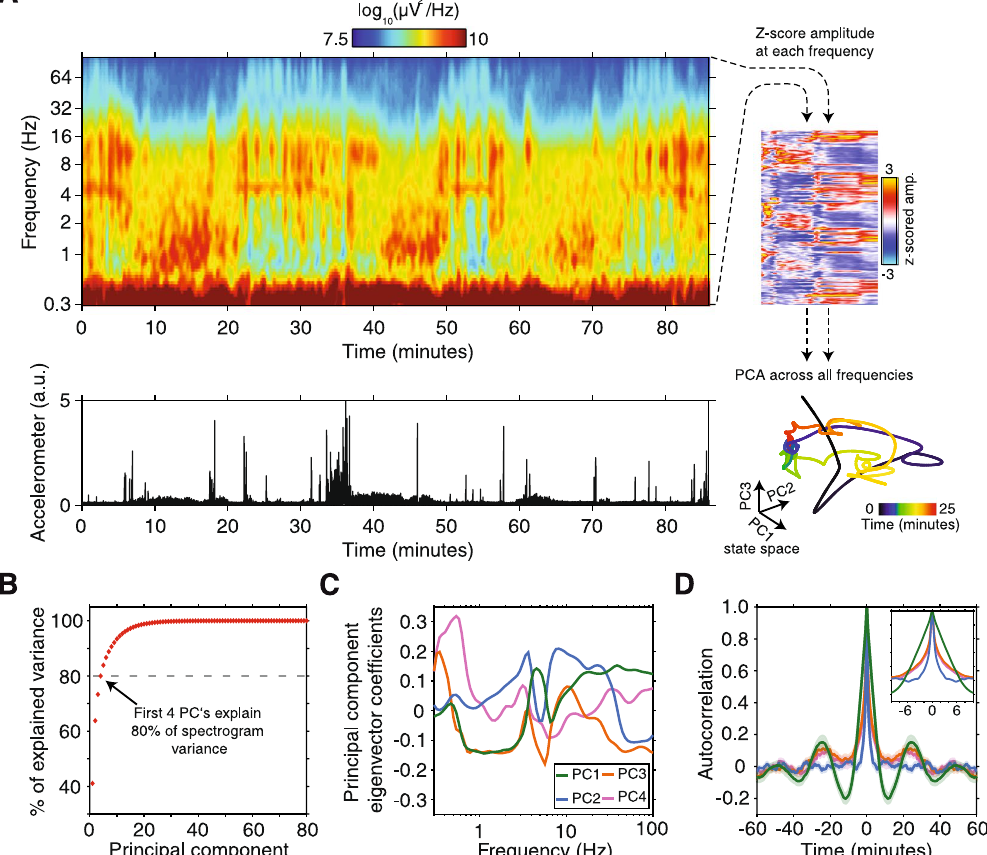
Figure 2. State-dependent fluctuations in spectral power and projection of neural data into PCA-derived state- space. ( A ) A representative example µ ECoG power spectrogram from an electrode placed over visual cortical area 21. Accelerometer power is plotted below the spectrogram to show how animals behavioral state changed over the duration of the recording. Note the recurring fluctuations in LFP power in the delta (0.8–3 Hz), theta (4–6 Hz), alpha (8–16 Hz), and gamma (30–80 Hz) frequency bands that track transitions in animal state. PCA was performed on the z-scored amplitude spectrogram (upper right, 90° rotated) to capture state-dependent fluctuations in LFP amplitude and project data into state-space (lower right). ( B ) The amount of variance explained by each principal component for the representative recording used to compute PCA coefficients. The first four principal components cumulatively explain more than 80% of total spectrogram variance ( C ) Principal component eigenvector coefficients for the first four principal components as a function of LFP frequency. Note that each component captures state-dependent fluctuations in LFP amplitude across several frequency bands. ( D ) The mean autocorrelation of principal components across all recording sessions and animals ( ± SEM). The prominent side peaks of principal components 1, 2 & 3 at ± 23 minutes reflect the periodic nature of spectral properties captured by these components, and match the reported duration of sleep/wake cycles. In contrast, principal component 2 displayed no side peaks and a much shorter half-width (blue trace), indicating that this component captures rapid and aperiodic fluctuations in spectral